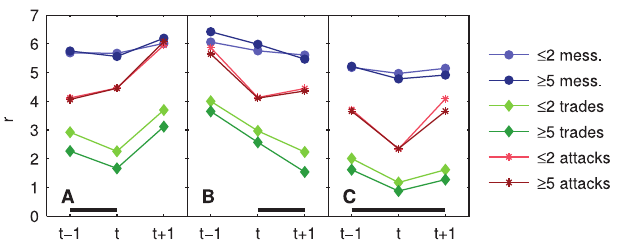
Fig 6. Relative distance r β of players before and after interactions. The black line indicates the time interval where interactions take place. A the players interact on the first day, but not on the second, B the players interact on the second day, but not on the first, C the players interact on both